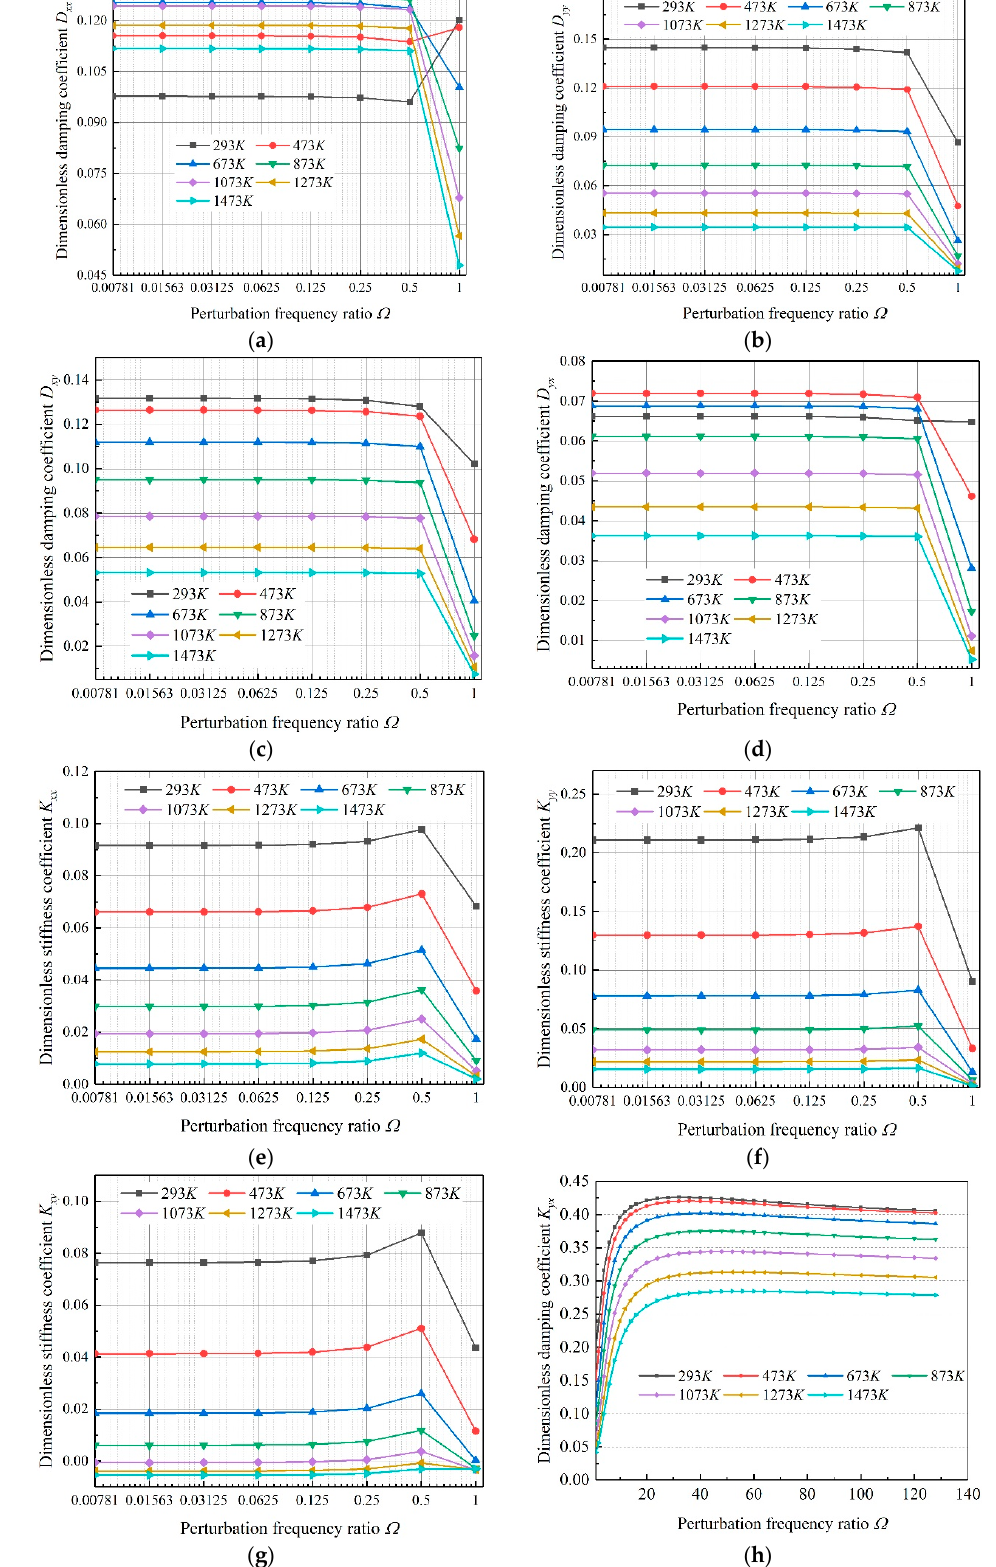
Figure 10. Influence of temperature on the 0 dynamic limit coe ffi cients. ( a ) D xx ; ( b ) D yy ; ( c ) D xy ; ( d ) D yx ; ( e ) K xx ; ( f ) K yy ; ( g ) K xy ; ( h ) K yx